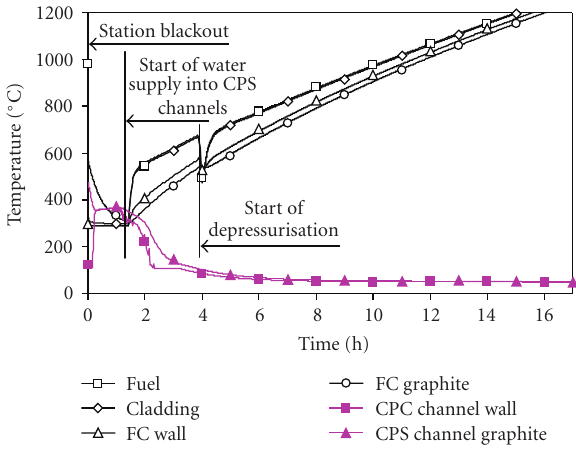
Figure 7: Station blackout case. Heat removal using CPS channels is not taken into account. Behaviour of core components tempera- tures.